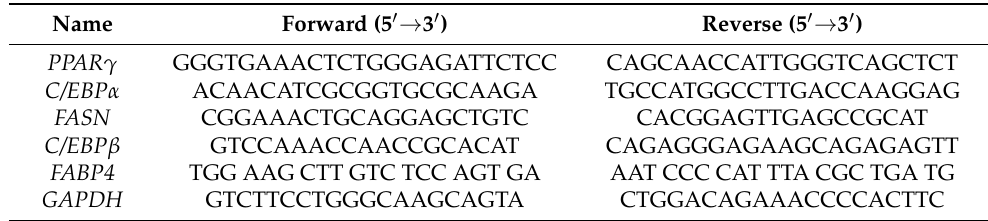
Table 1. List of primers used for quantitative